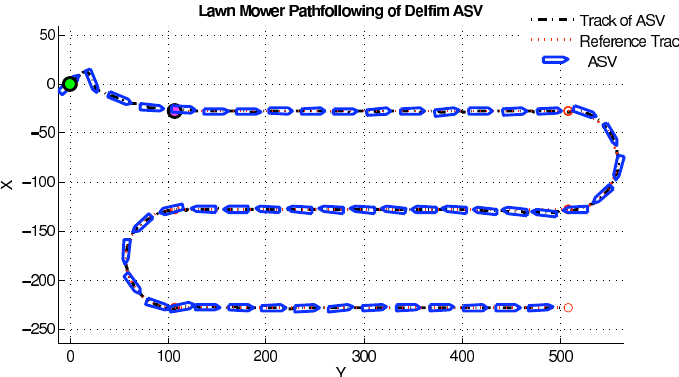
Figure 18. Delfim x performing a lawn-mowing maneuver in the Azores, PT.